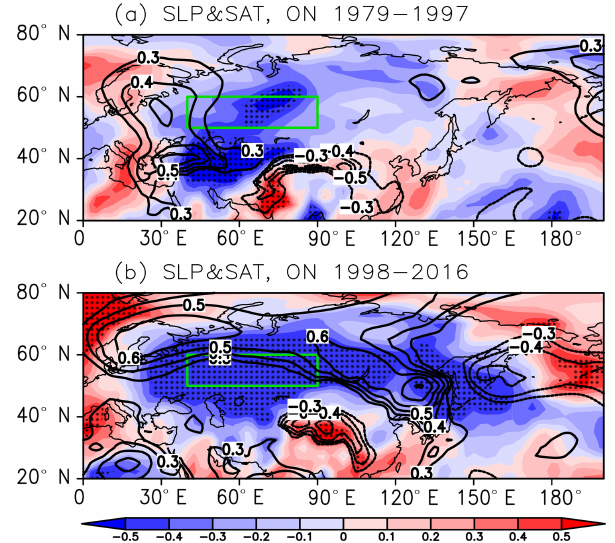
Figure 12. The CC between the SC ES and SAT (shading) and SLP (contour) in October–November (a) from 1979 to 1997 and (b) from 1998 to 2016. The black dots indicate the CC exceeded the 95% confidence level ( t test). The green box represents the ES area. The linear trend is